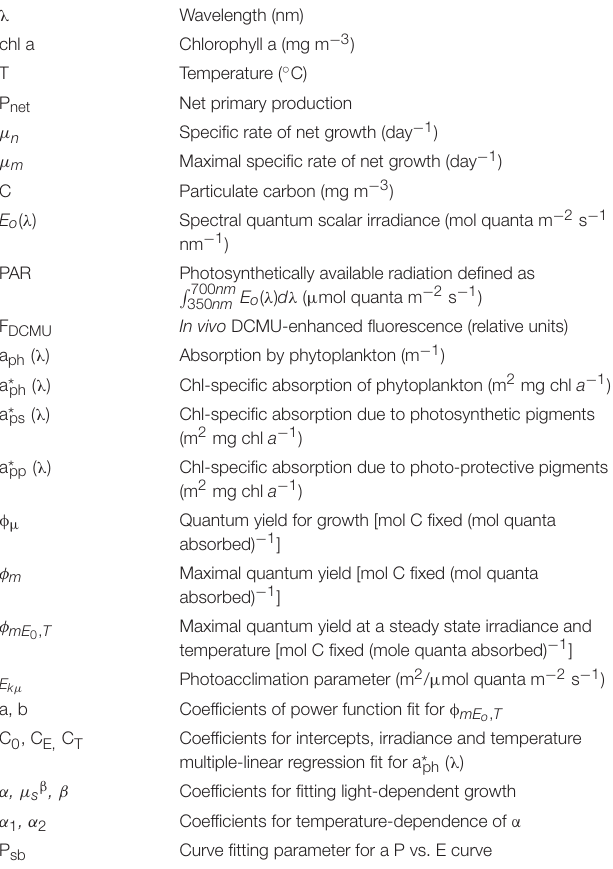
TABLE 1 | Symbols used throughout the